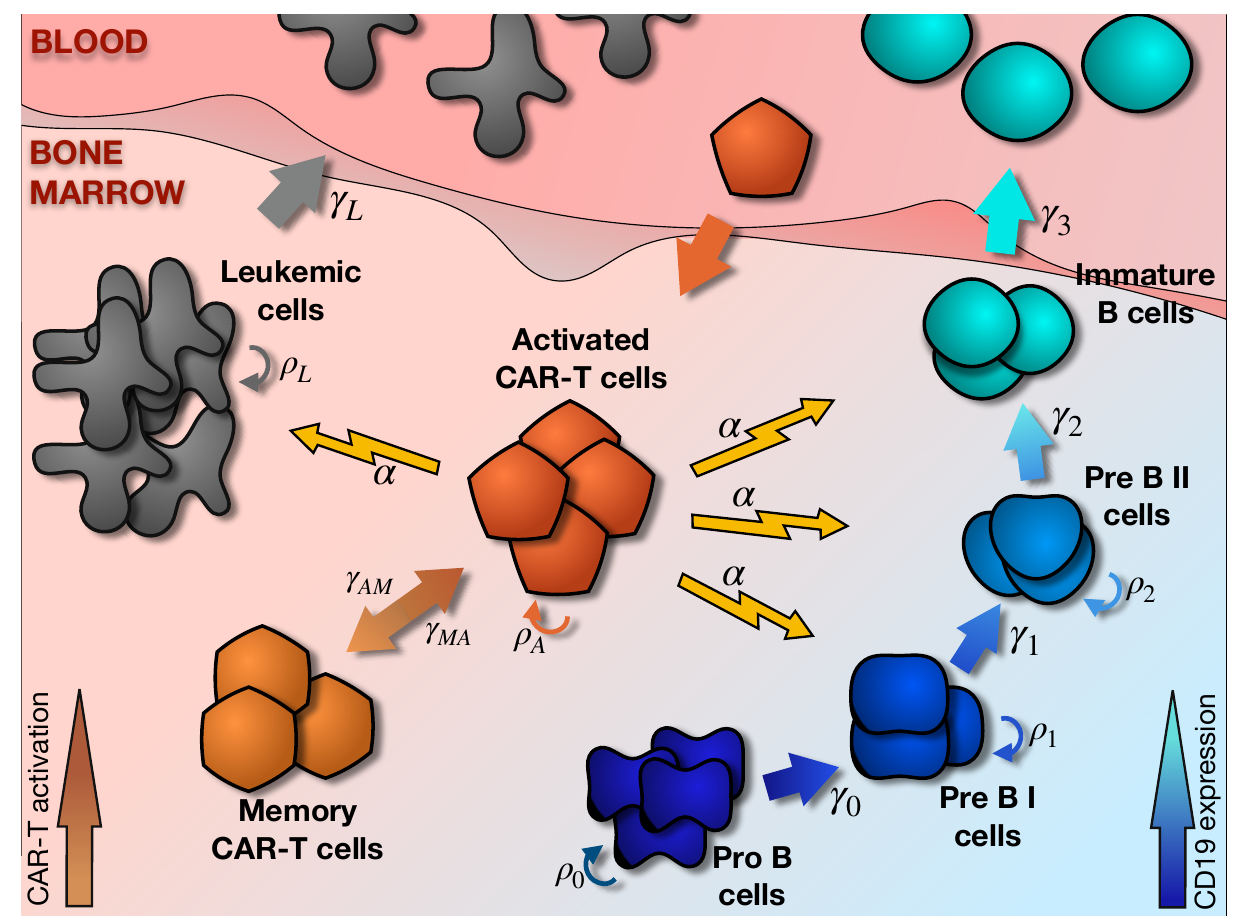
Figure 1. B cells progressively express CD19 as they become more mature. Four maturation stages were considered, namely Pro B, Pre BI, Pre BII, and immature B cells. These cell types were assumed to proliferate with rate ρ i ( i = 0, . . . ,2) and progress with rates γ j ( j = 0, . . . ,3), except for immature B cells that no longer proliferate, leaving bone marrow with an exit rate γ 3 . Leukemic cells originate from a B-cell precursor and proliferate with rate ρ L , invading the bone marrow and eventually migrating to peripheral blood with an exit rate γ L . CAR T-cells are assumed to travel to bone marrow from blood and proliferate with rate ρ C upon encounters with CD19-expressing cells. They carry out effector functions on CD19 expressing cells with killing capacity α . Pro-B cells are not affected by this action since they do not express CD19. Part of the activated CAR T pool becomes long-lived memory cells with rate γ AM . These cells can regain effector function upon repeated exposure to CD19, with reactivation rate γ MA